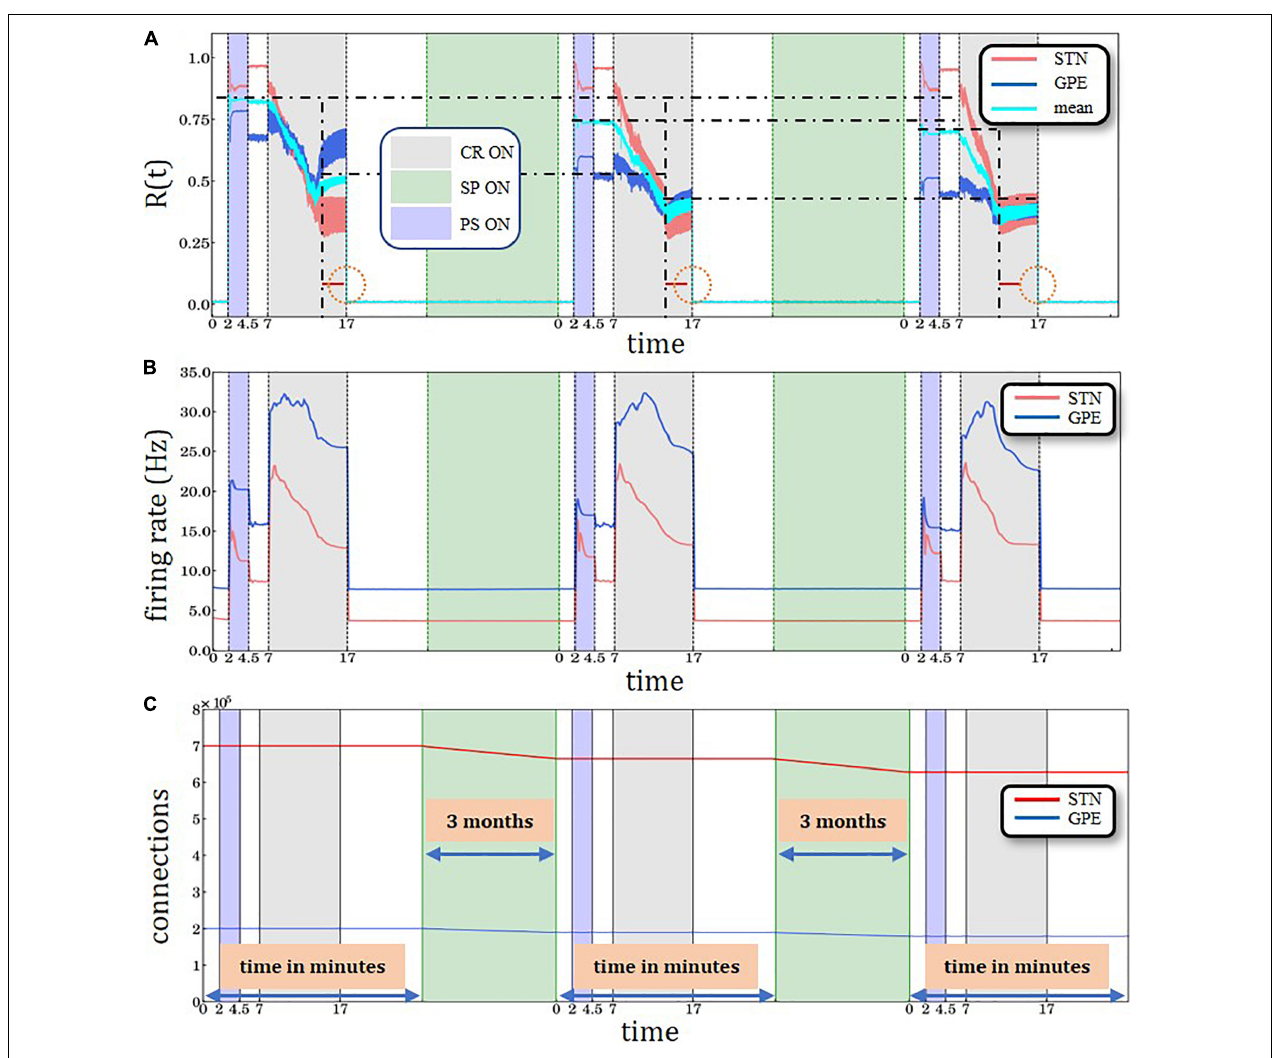
FIGURE 4 | Three identical PS-CR sequences, with structural plasticity with 3.0 Hz target firing rate. (A) A sliding window of 100 simulation time steps at each different epoch when STDP or structural plasticity was active for STN (red solid line) and GPe (blue solid line) neurons and the average value for the whole network (cyan solid line). The horizontal back dot-dashed lines indicate the plateaus’ gradual decrease of the level of synchronization degree after each SP period interval. The vertical black dot-dashed depict the gradual improvement of the CR’ performance after each consecutive stimulation and SP cycle. The lines’ respective location is set at the beginning of the plateaus immediately after the initial sharp decrease. The equally sized horizontal red lines and the circle are used to provide a visual aid to this effect. (B) Spiking rates for STN and GPe neurons, respectively. PS, CR, STDP, and structural plasticity activation interval period. The color coding and time units are defined in the legends of panels (A,C) . (C) Time course of the total number of synaptic excitatory connections in the STN